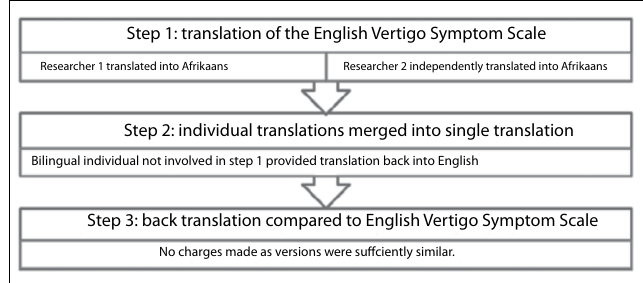
Fig. 1. Flow chart depicting the translation of the Vertigo Symptom Scale into